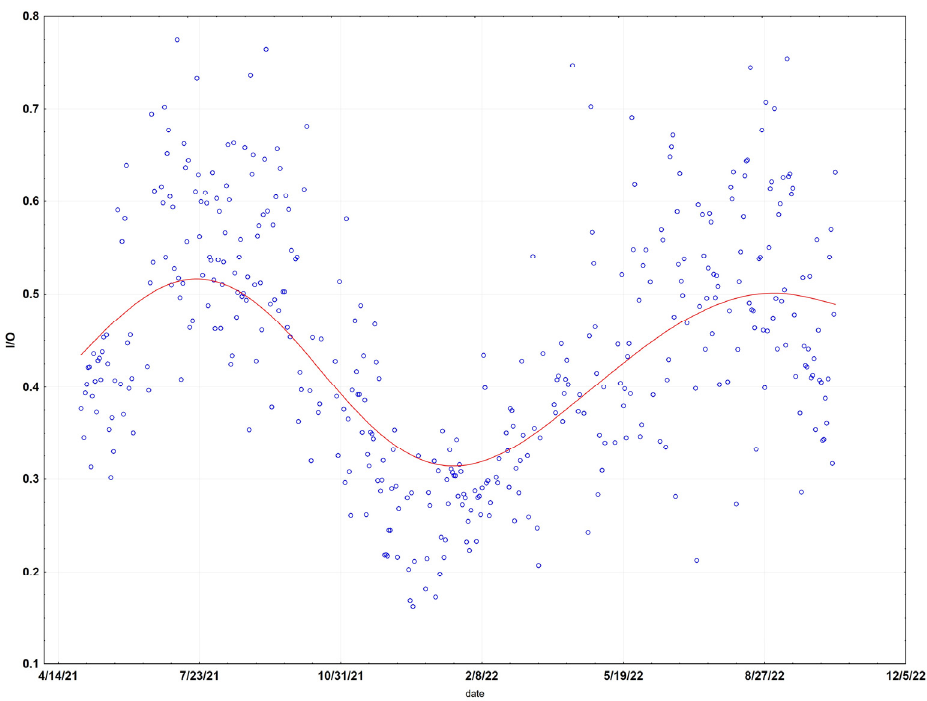
Figure 8. Indoor-outdoor (I/O) ratio of daily means at the Redwood City site.